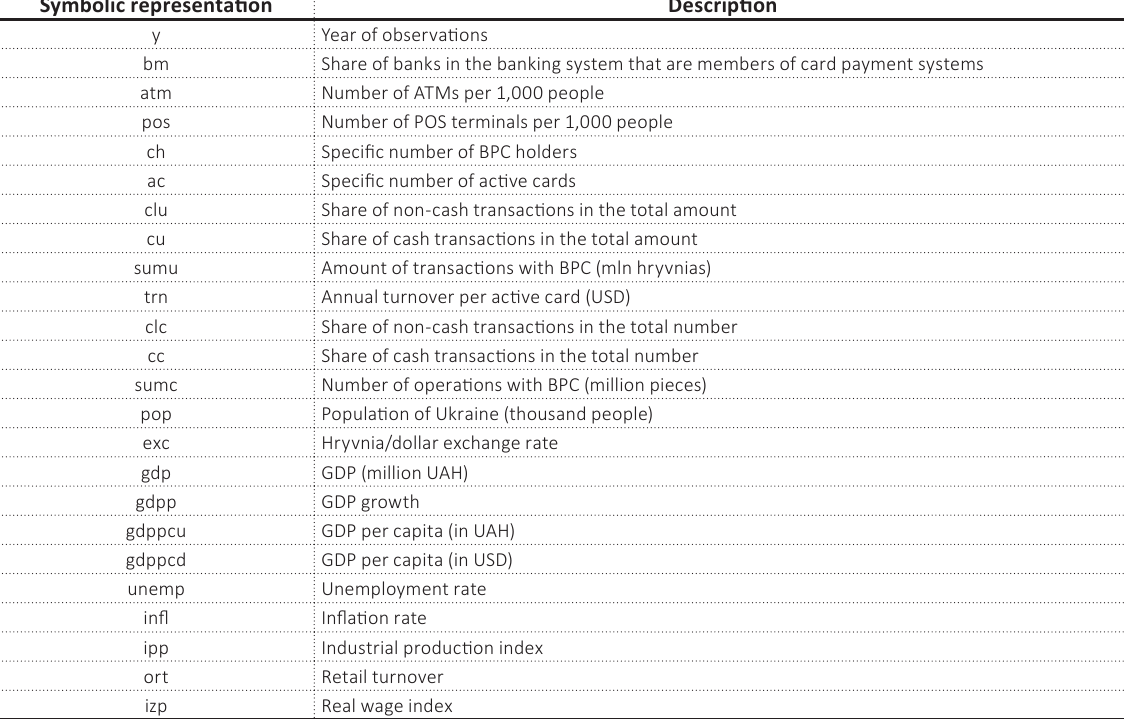
Table А1. Indicators and their symbols at the stage of analysis of the mutual influence of the studied